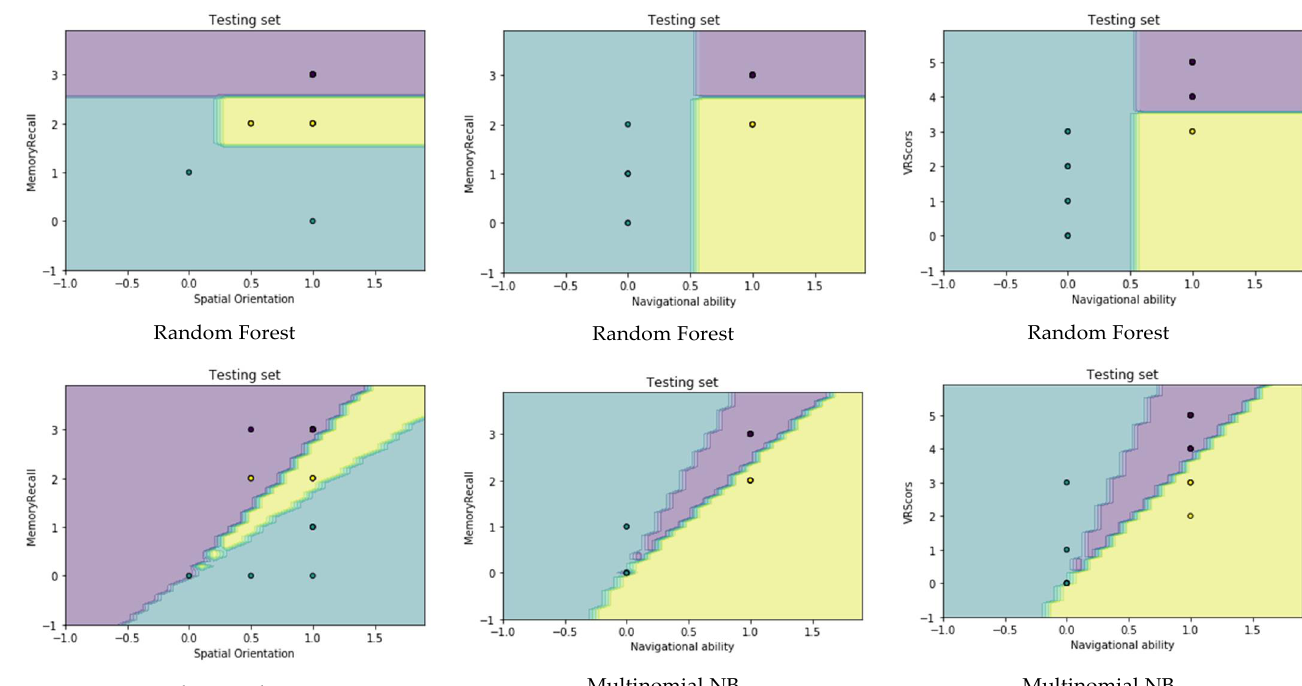
Figure 10. Decision boundaries of a classifier given 2D features. Note: purple color noted to cognitively health class, yellow color noted to MCI class, green color noted to demented class